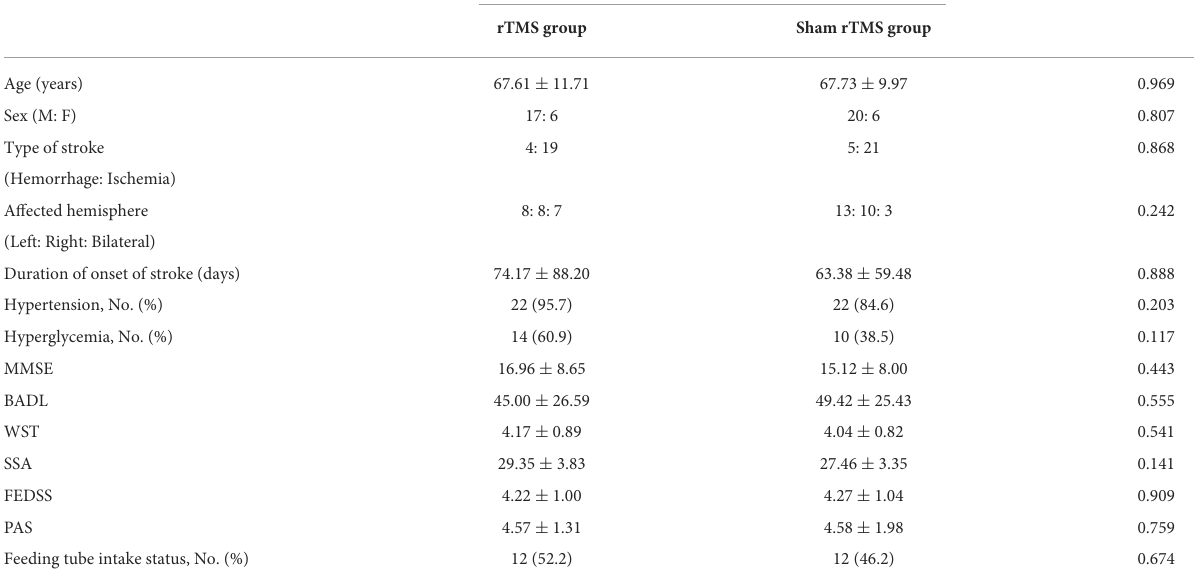
TABLE 1 Baseline demographic and clinical